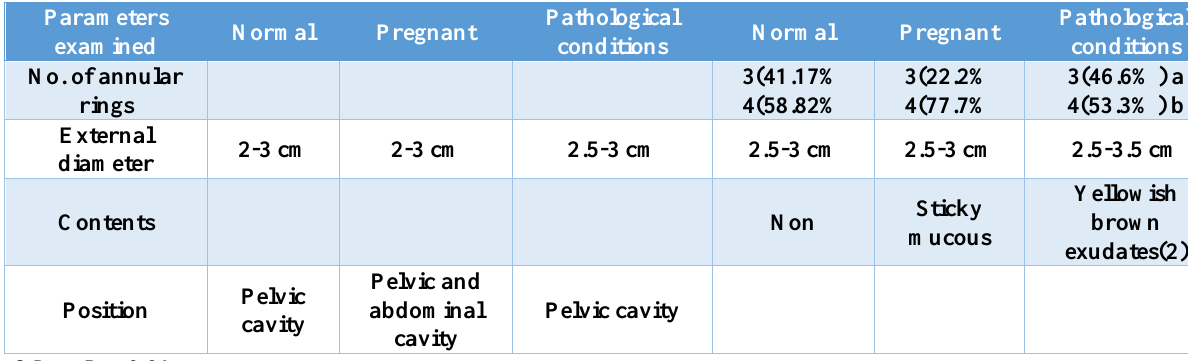
Table, 2: Pre and post slaughter findings in the examination of the cervix. Pre slaughter (Rectal palpation)